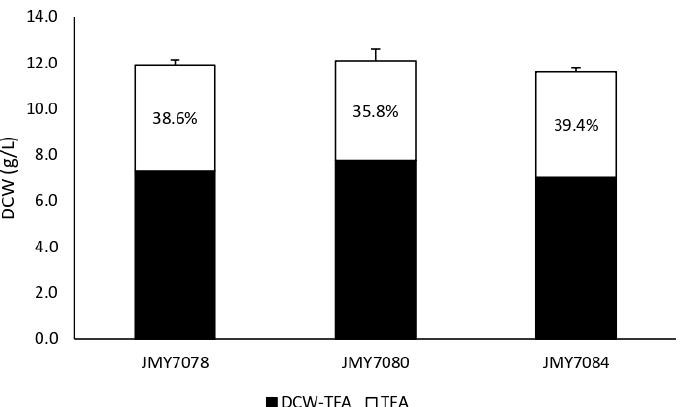
Figure 4. Biomass and lipid accumulation of JMY7078 ( 8UAS-pTEF-MsexD2 ), JMY7080 ( 8UAS-pTEF- MsexD3 ), JMY7084 ( 8UAS-pTEF-MsexD2, 8UAS-pTEF-MsexD3 ) cultured in MedA+ with glucose as the carbon source. Textured area represents Lipid free biomass (g/L) and grey area represents total fatty acids (g/L). Lipid accumulation (%) is expressed as a TFA to DCW ratio. Each value is an average of the values obtained from three independent experiments.